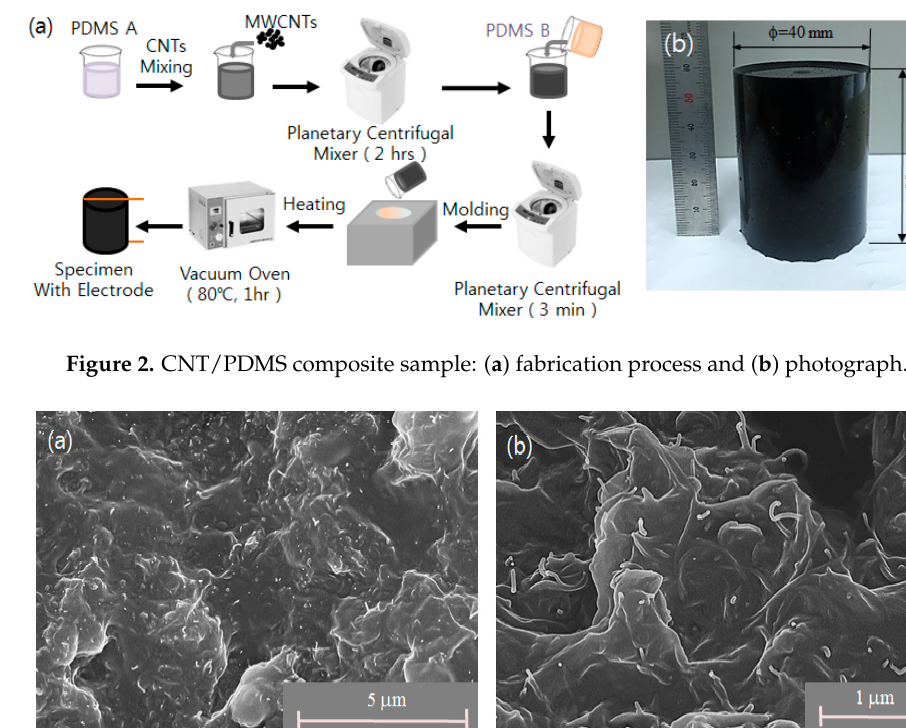
Figure 1. The electrical conductivity of the CNT/PDMS composites as a function of CNT concentration (adapted from Ref. [14]).